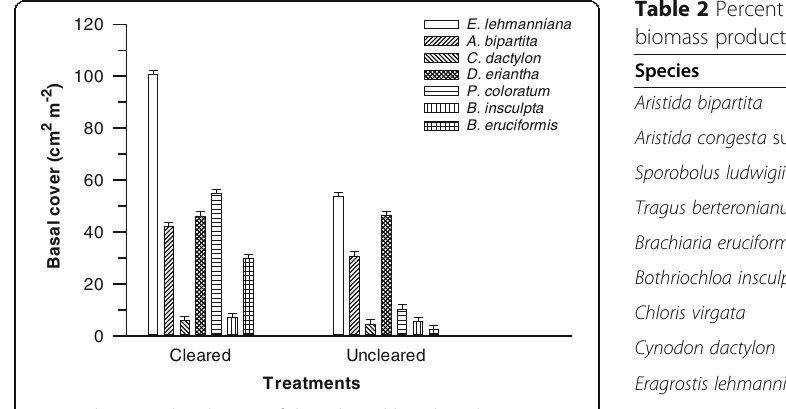
Fig. 3 The mean basal cover of the selected bunch and creeping grass species in cleared and uncleared sites. Bars indicate the mean values, and the whiskers indicate the standard errors. Key to species: E. lehmanniana , Eragrostis lehmanniana ; C. dactylon , Cynodon dactylon ; P. coloratum , Panicum coloratum ; B. eruciformis , Brachiaria eruciformis ; A. bipartita , Aristida bipartita ; D. eriantha , Digitaria eriantha ; B. insculpta , Bothriocloa